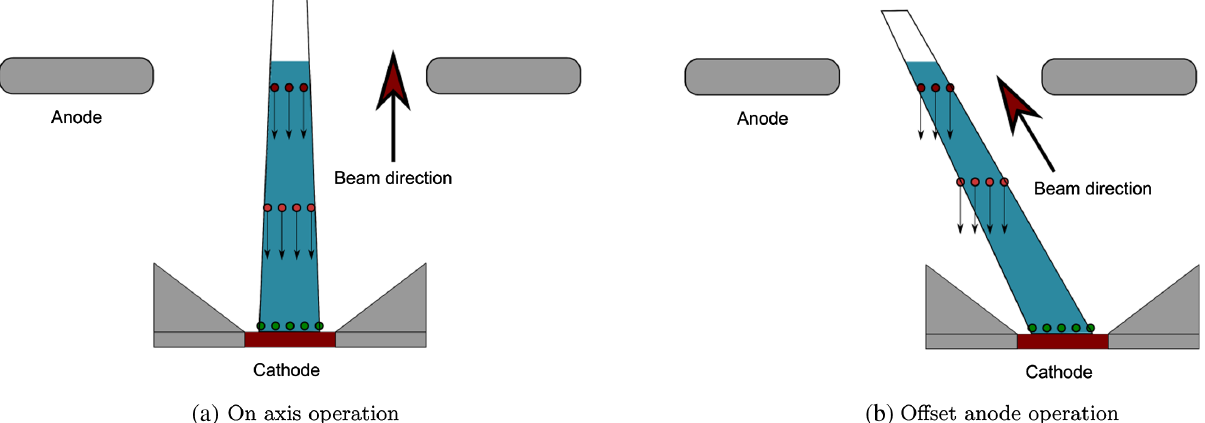
FIG. 1. Ion generation at different points along the beam path in the dc gap for on-axis and offset-anode scheme. Green, light red and dark red circles indicate low, medium and high energy ions. The arrow on the ion circles indicates general direction towards which the ions tend to move. Effect of focusing on the medium and high energy ions are not shown.